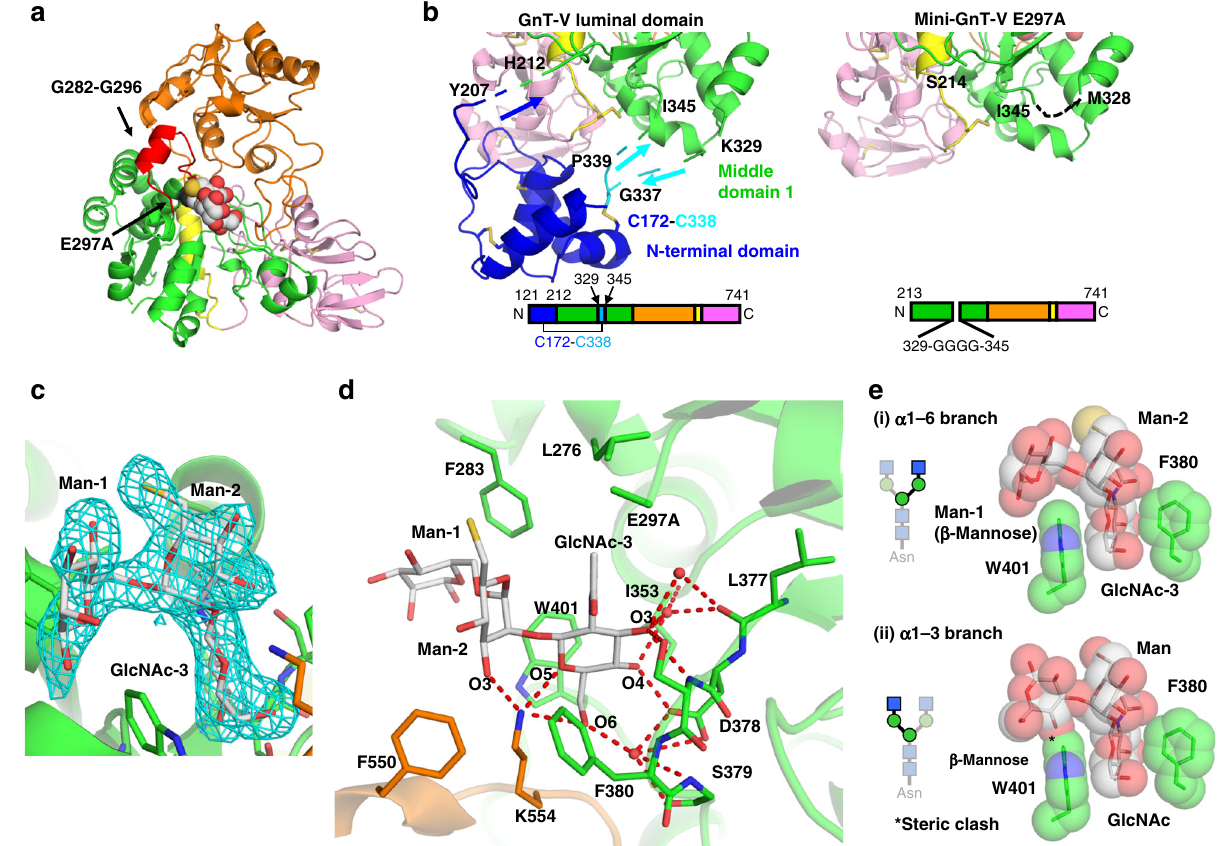
Fig. 3 Structure of mini-GnT-V E297A in complex with bisubstrate-type inhibitor. a Crystal structure of mini-GnT-V E297A in complex with bisubstrate- type inhibitor. Trisaccharide is shown in sphere model. Highly mobile region (G282-G296) and E297A are colored with red and black, respectively, and indicated. b Close-up views of domain boundary between N-terminal domain and middle domain 1 in GnT-V luminal domain (left panel) and mini-GnT-V E297A (right panel). Key residues of these two structures are labeled. Domain architectures are shown in bottom. c Omit map contoured at 3.0 σ level around acceptor binding site is shown in cyan mesh. Carbohydrate and amino-acid residues are shown in rod models. d Close-up view of interaction with acceptor trisaccharide. Direct and water-mediated interaction network is depicted with red dotted lines. Three water molecules, which link glycan and mini- GnT-V are conserved in the two complexes. Details of interaction network are also summarized in Supplementary Table 2. e Two aromatic residues, F380 and W401, restrict the conformation of trisaccharide and de fi ne the branch speci fi city. Two aromatic rings and trisaccharide residues are shown in rod and semi-transparent sphere models. The interaction of α 1-6 branch observed in crystal structure (i) and docking model of α 1-3 branch (ii) are shown in upper and lower panels, respectively. Steric clash is shown in